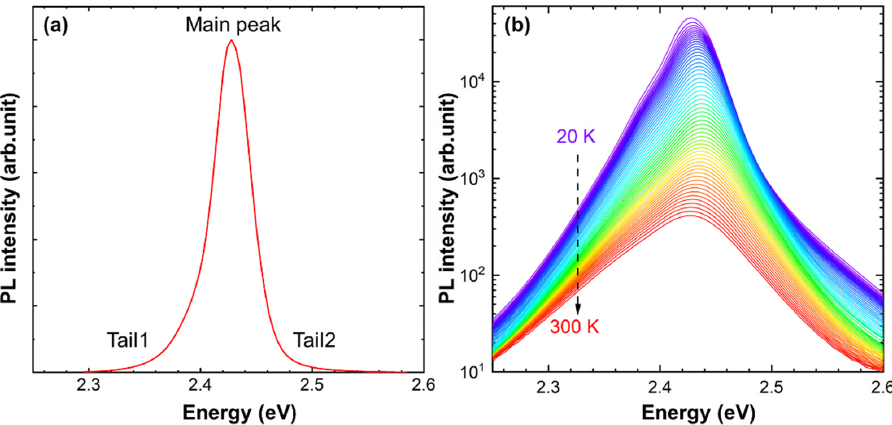
Figure 1. The PL spectra of GC ‐ Ca ( a ) in a linear scale, ( b ) in a log scale at different temperatures.